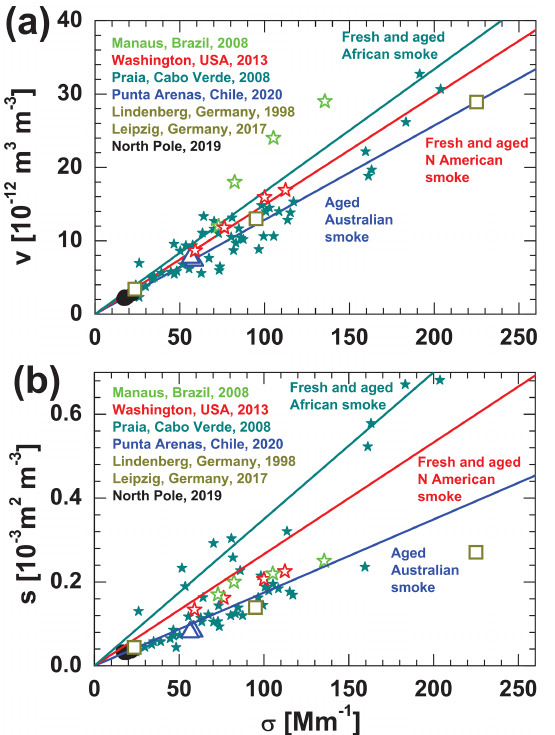
Figure 9. Same as Fig. 6a and b, except for a correlation between (a) lidar-derived v and σ and (b) lidar-derived s and σ . The closed dark green stars indicate lidar observation of fresh and aged western African smoke taken in January and February 2008. The open green and red stars show lidar observations in Brazil and the USA of mix- tures of fresh and aged smoke during the summer seasons of 2008 and 2013, respectively. The two open blue triangles (Punta Arenas), three open squares (Lindenberg, Leipzig, Germany), and the black circles in the lower-left corner (North Pole region) are representa- tive for aged smoke. The thick blue, red, and green lines show the mean increase in v and s with σ for aged Australian smoke (blue), mixtures of fresh and aged North American forest fire smoke (red), and mixtures of fresh and aged southern African smoke (green).